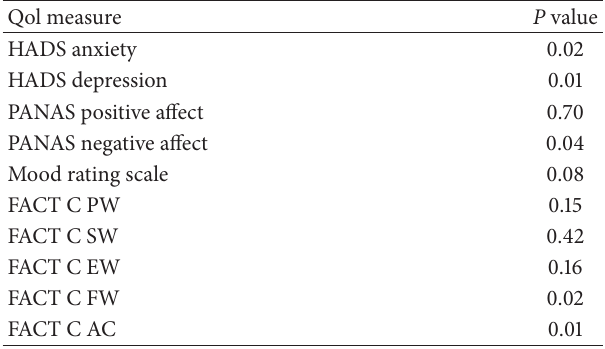
Table 5: Univariate analysis of postoperative Qol and